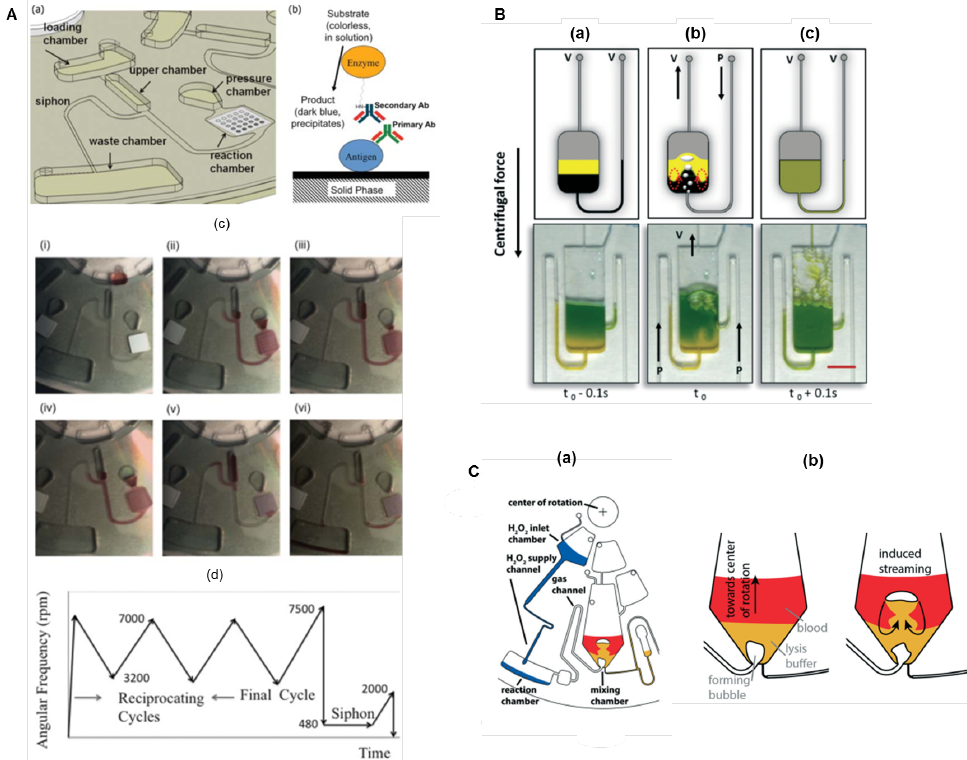
Figure 9. ( A ) Pneumatic pressure flow-based reciprocating mixing. Schematics of ( a ) the fluidic system and ( b ) the antibody capture assay to take place in the reaction chamber; ( c ) images of the system in operation: (i) sample is loaded; (ii) the increase in the rotation frequency promotes the air